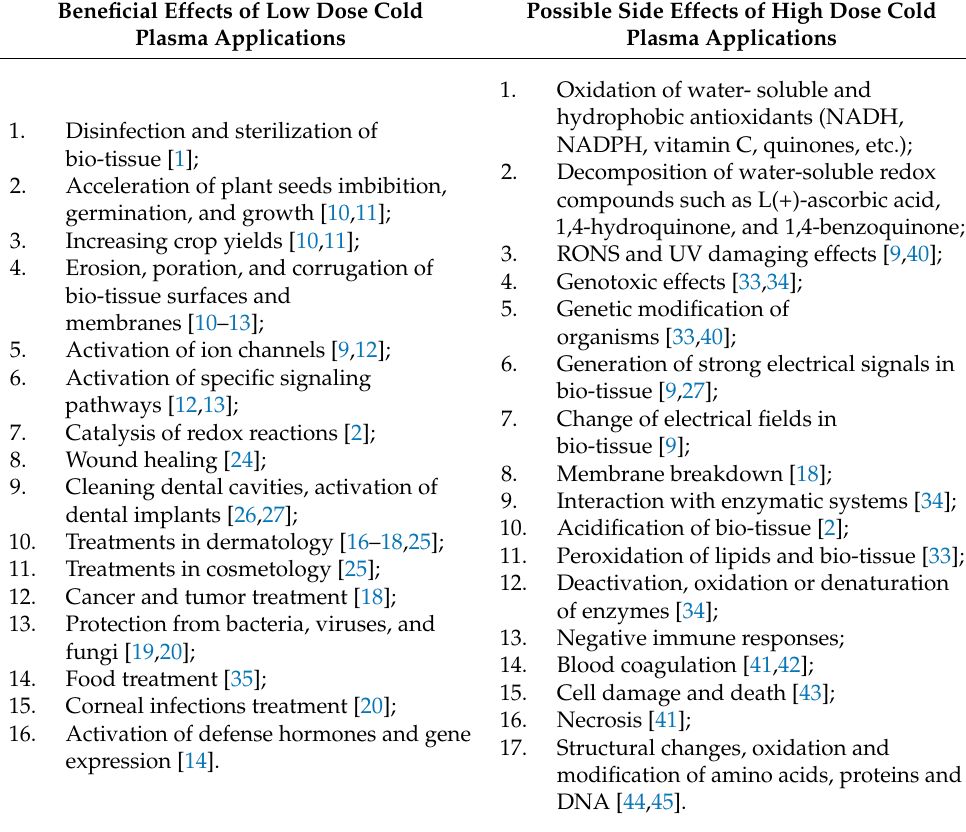
Table 1. Cold atmospheric pressure plasma has beneficial and side effects on biological